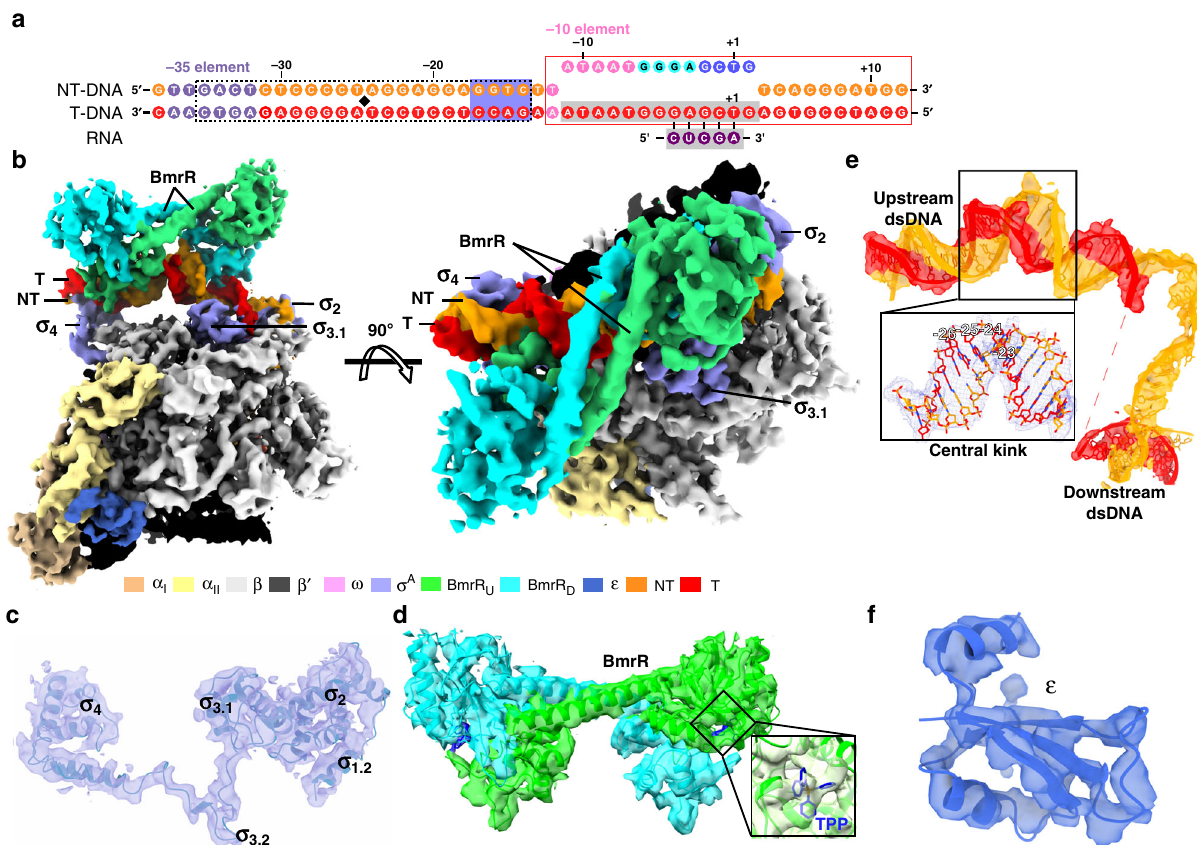
Fig. 1 The cryo-EM map and model of B. subtilis BmrR transcription activation complex (BmrR-TAC). a Nucleic acid scaffold used for cryo-EM structure determination of BmrR-TAC. Black diamond, the center of BmrR operator; orange, non-template DNA; red, template DNA; light blue, − 35 element; pink, − 10 element; cyan, discriminator element; blue, core-recognition element; purple, RNA; dashed box, BmrR operator DNA; gray shaded box, disordered nucleotides in the structure; red box, sequenced modi fi ed for improving complex stability; and blue shaded box, the extended − 10 region. b The top and front view-orientations of cryo-EM map of B. subtilis BmrR-TAC. The RNAP subunits, nucleic acids, and BmrR are colored as in the color scheme. c The cryo-EM map and model for B. subtilis σ A . d The cryo-EM map and model for B. subtilis BmrR dimer. The box highlights the map for tetraphenylphosphonium (TPP) in the BmrR-LBD. e The cryo-EM map and model for the promoter DNA. The inset box highlights the promoter central kink. f The cryo-EM map for B. subtilis RNAP- ε subunit. The cryo-EM maps were contoured at 0.00924 and structure fi gures were prepared in Chimera